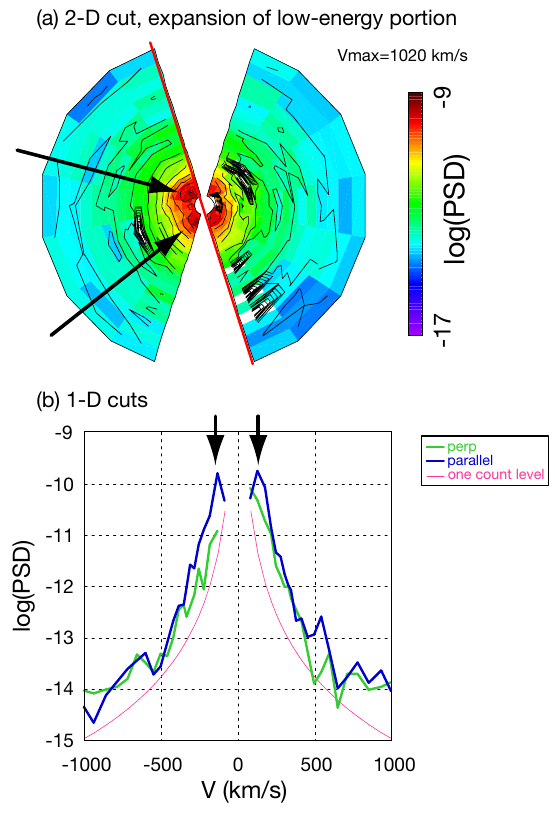
Fig. 6. An expansion of the low-energy portion of the ion distribu- tion function between 08:00:24–08:00:36 UT (the same data shown in Fig. 5d). The upper panel (a) shows a 2-D cut in the plane that includes the local magnetic field. Counter-streaming beams (high- lighted by black arrows) along the local magnetic field are apparent. The lower panel (b) presents 1-D cuts in the directions perpendicu- lar (green) and quasi-parallel (blue) to the magnetic field. Two red curves correspond to the one count level of the detector. Since the direction purely parallel to the magnetic field was out of sight of the detector, the phase space density in the quasi-parallel direction is